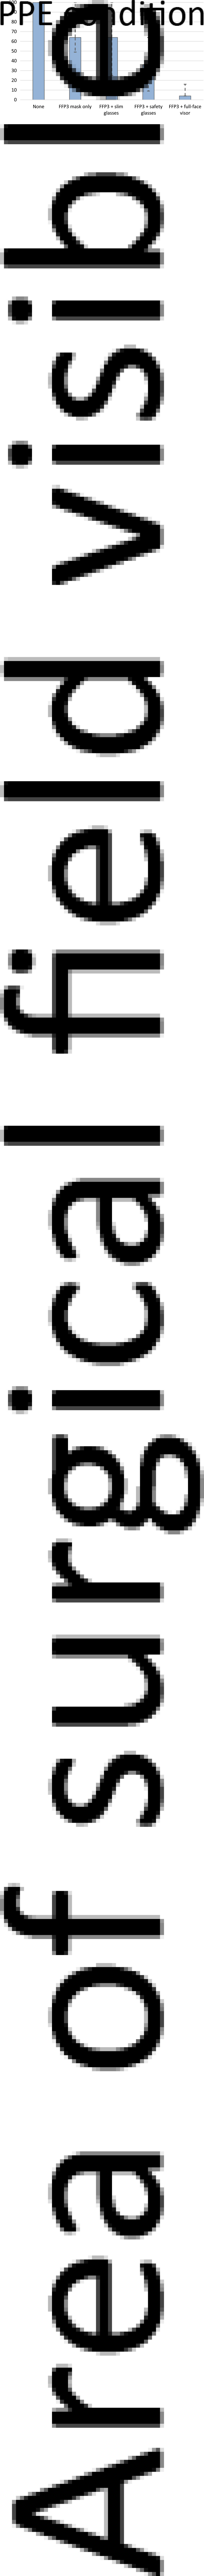
Area of target visible with each personal protective equipment (PPE) condition (median values shown with minimum–maximum range bars). FFP3 = filtering facepiece code 3